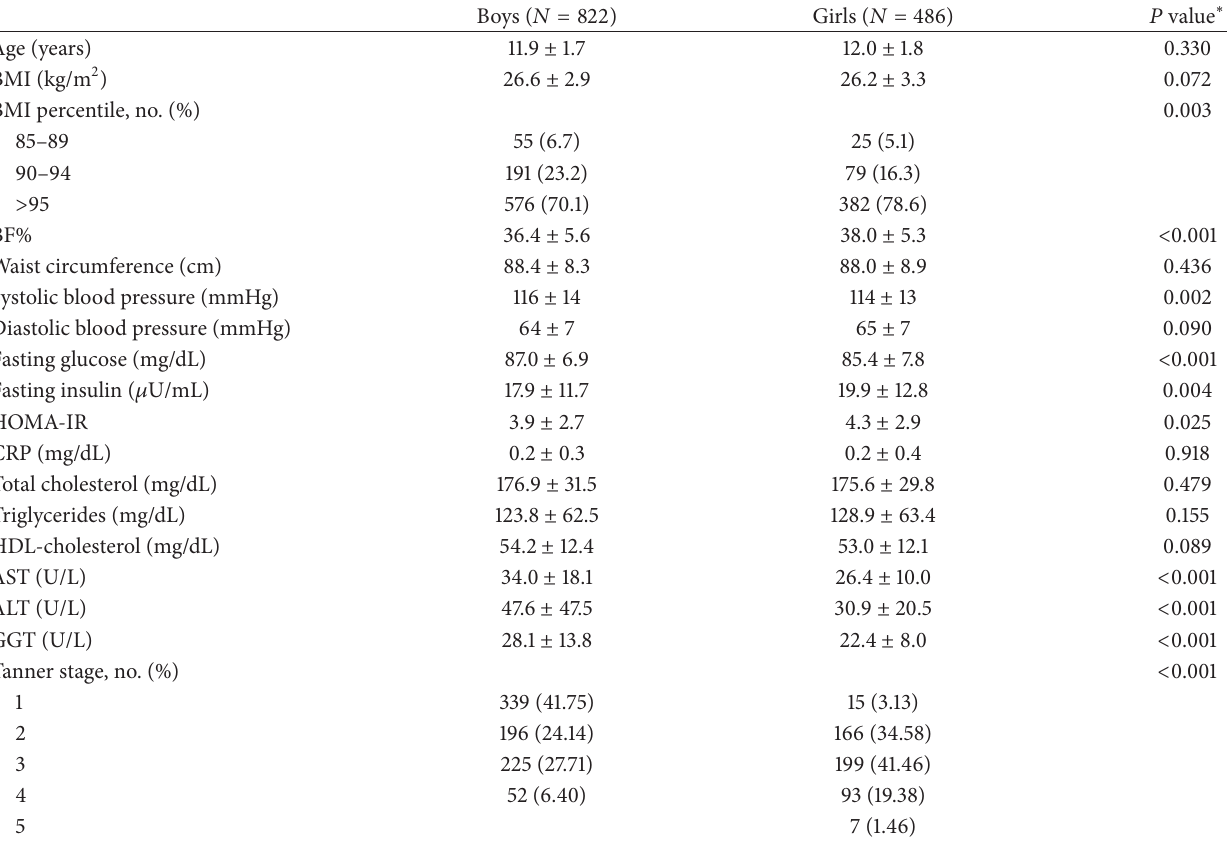
Table 1: Basic characteristics of the subjects (total no. =